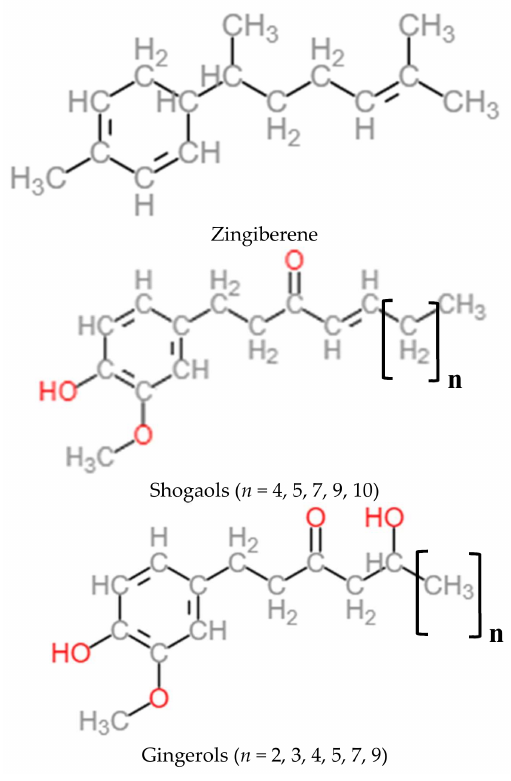
Figure 2. Chemical structures of active constituents: zingiberene, shogaols, and